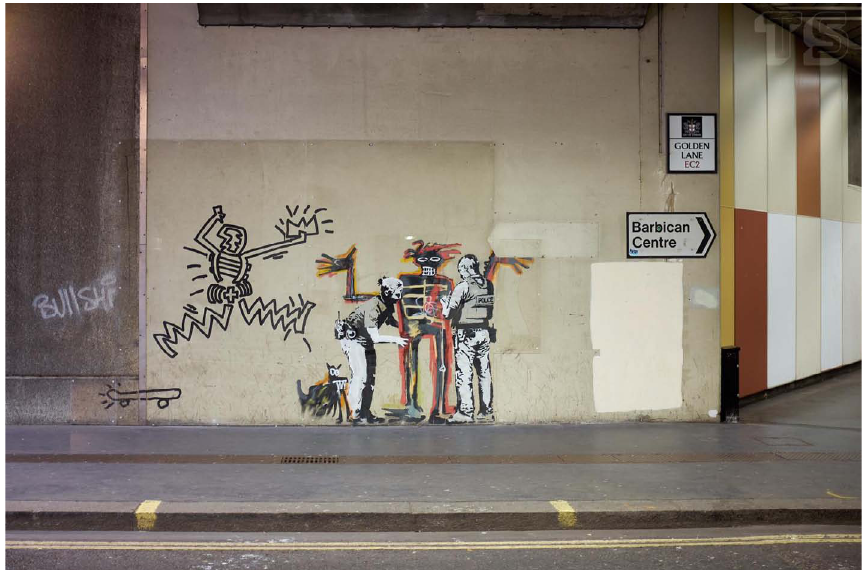
Figure 18. Banksy’s tribute to Jean- Michel Basquiat on Barbican Centre, protected by Plexiglas. London